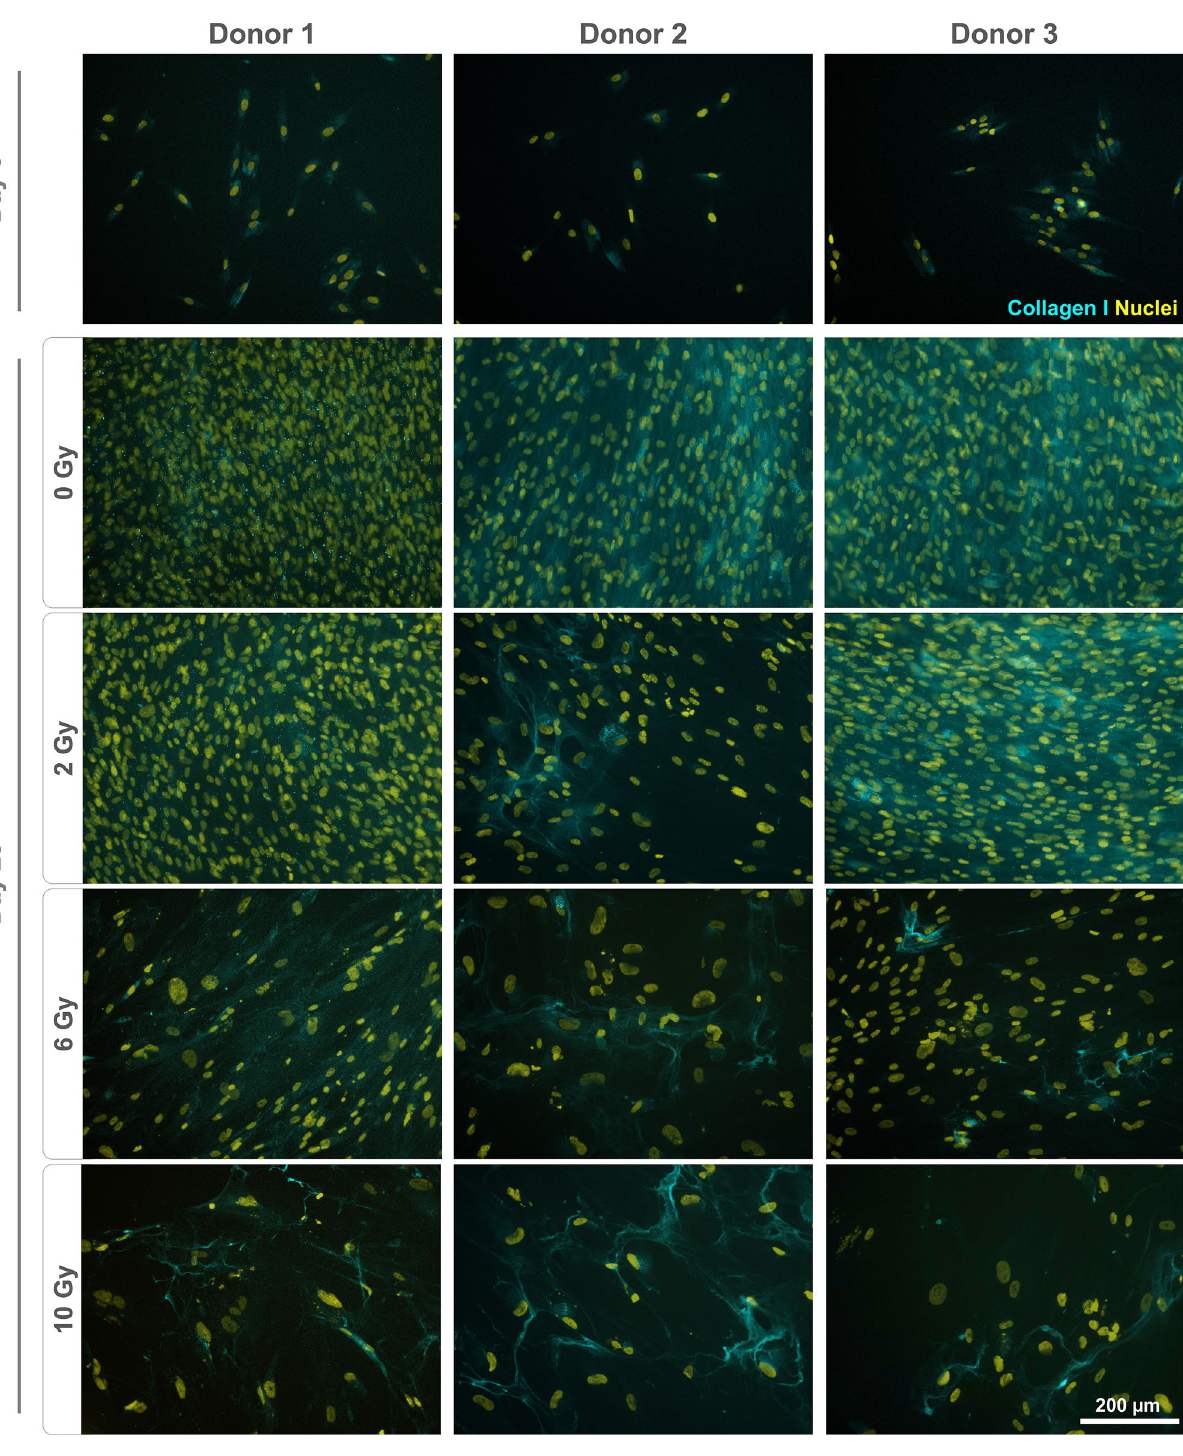
Expression levels of COL1A1 and RUNX2 appeared stable for non-irradiated cells over the course of the experiment. Upon irradiation, a tendency for a dose-dependent reduction of the expression was observable.